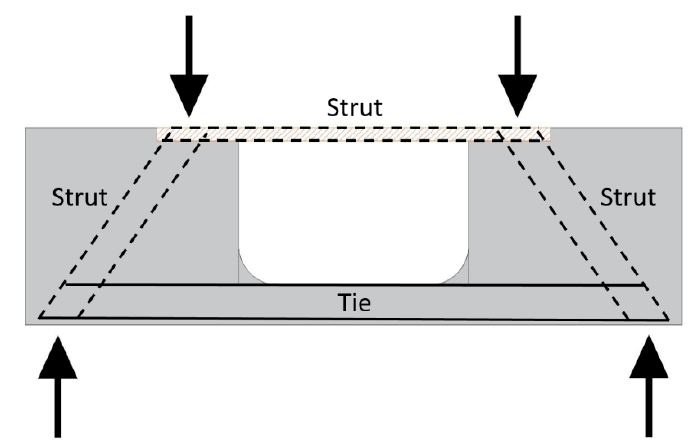
Figure 5. Force mechanism of strut-and-tie beam.